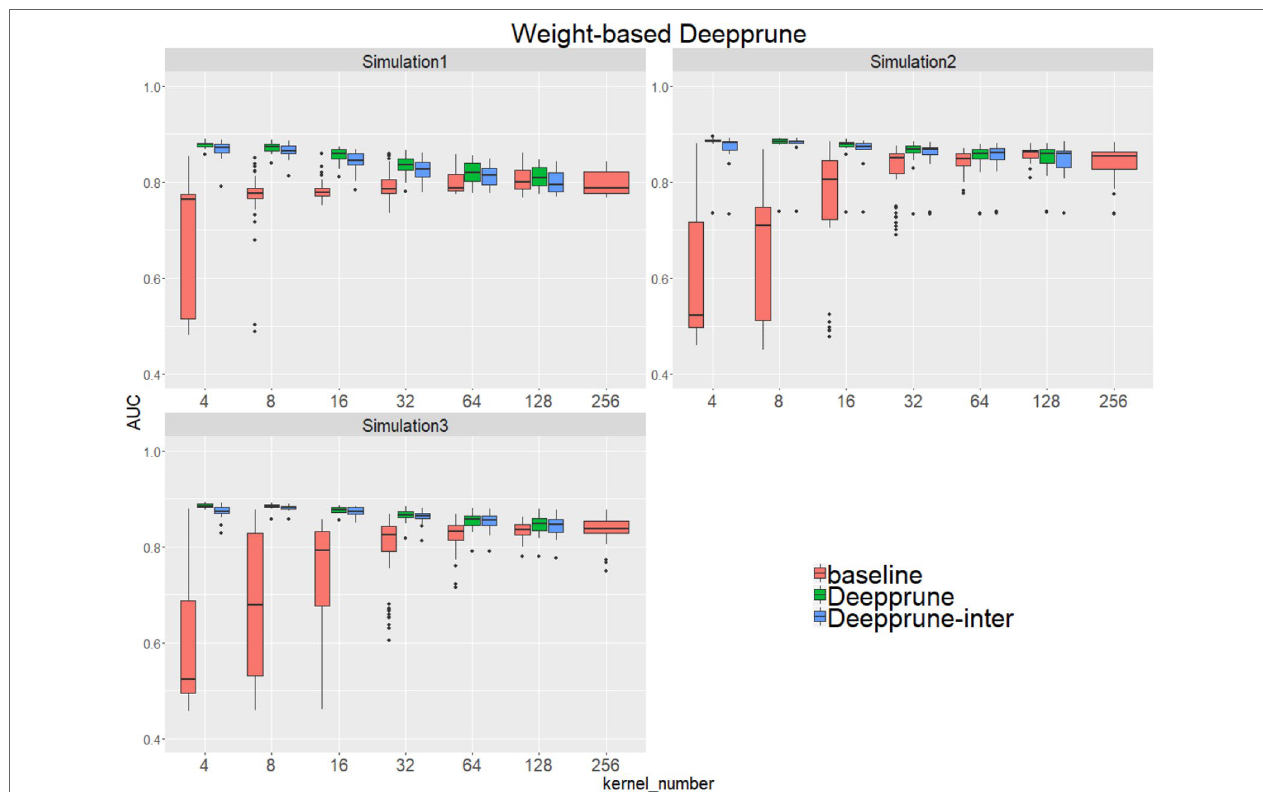
FIGURE 2 | Weight-based Deepprune performs much better and is much robuster to different random initialization than baseline when kernel number is limited in the first three simulated datasets. The x axis shows the kernel numbers utilized in the model, and the y axis shows the area under the receiver operating characteristic curves (AUCs) obtained in testing. As kernel number decreases, the performance of Deepprune shows a converse tendency compared to baseline; thus, as iteration continues in an upward gradient, the mean AUC of Deepprune significantly